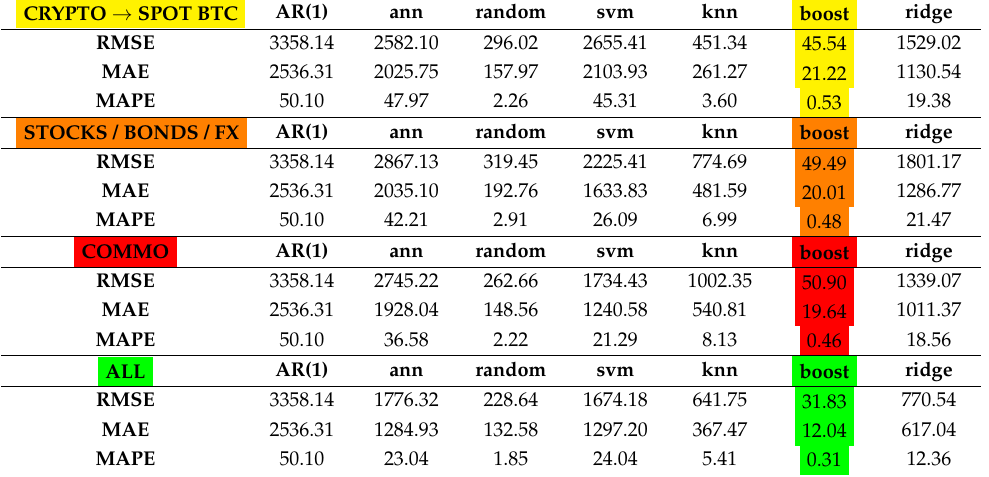
Table 6. Sub-sample with the Introduction of Tether (USDT): forecasting of the Coinbase Bitcoin Spot